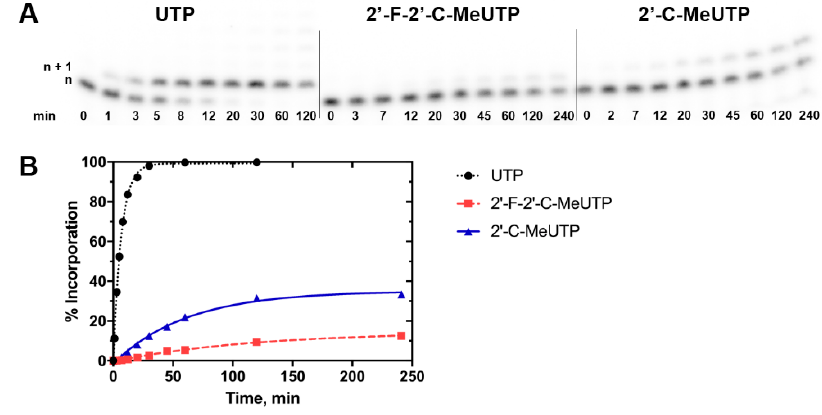
Figure 4. Kinetic characterization of nucleotide and nucleotide analogue incorporation by ZIKV RdRP . ( A ) ZIKV RdRP and primer/template (P/T) substrate (n) was mixed with excess UTP, 2’-F-2’- C-methyluridine triphosphate (2’-F-2’-C-MeUTP), or 2-C-methyluridine triphosphate